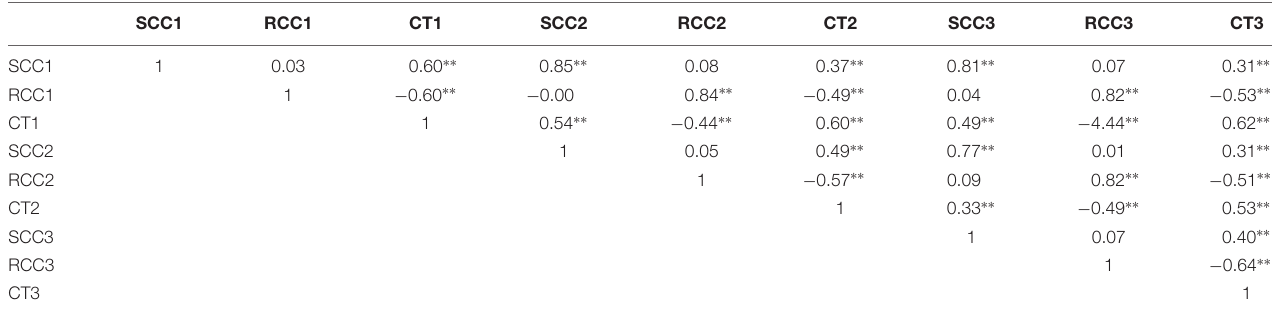
Trait: SCC1, shoot Cd concentration in E1; RCC1, root Cd concentration in E1; CT1, Cd translocation coefficient in E1; SCC2, shoot Cd concentration in E2; RCC2, root Cd concentration in E2; CT2, Cd translocation coefficient in E2; SCC3, shoot Cd concentration in E3; RCC3, root Cd concentration in E3; CT3, Cd translocation coefficient in E3. ∗ P < 0.05, ∗∗ P <